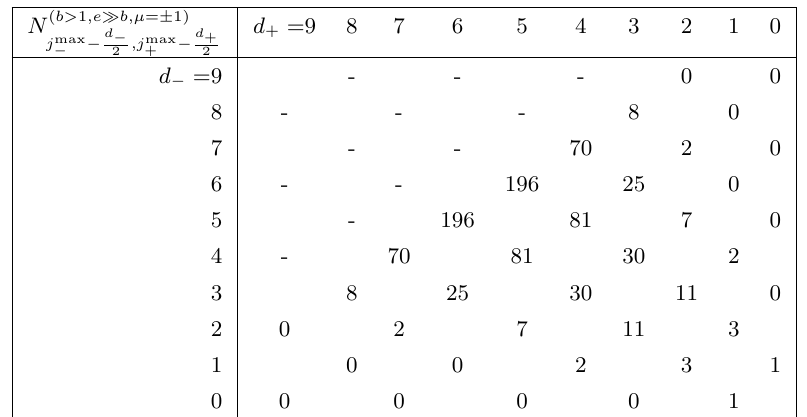
Table 8 . Asymptotics of refined BPS invariants of the massive M-string for µ odd. N (1 , 0 , 0) j − j +